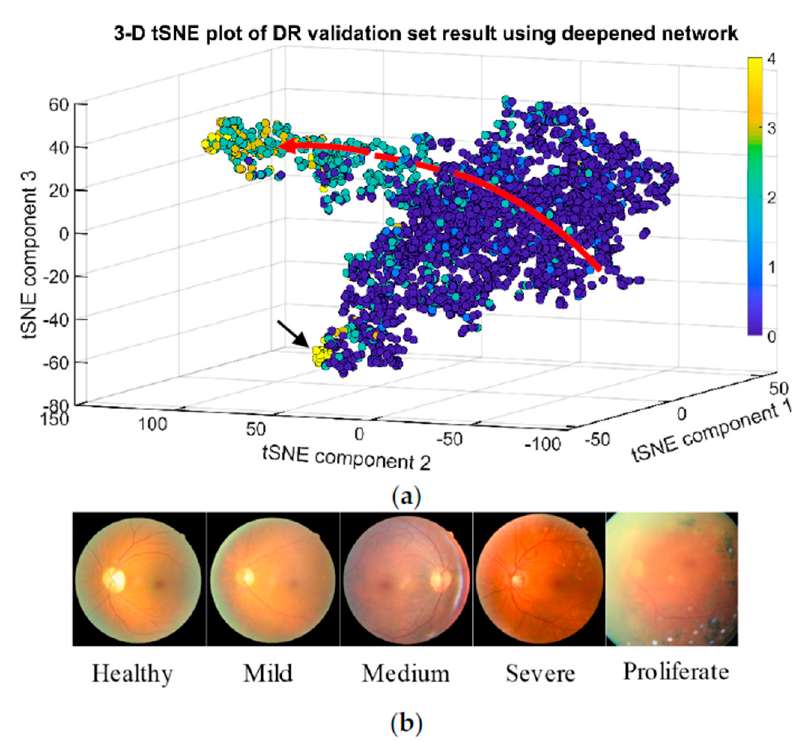
Figure 7. Reconstruction of disease progression in diabetic retinopathy by the deepened CNN. ( a ) tSNE visualization of validation image data set in activation space representation, colored according to corresponding disease phase. ( b ) Randomly picked repetitive fundus images that from each phase.